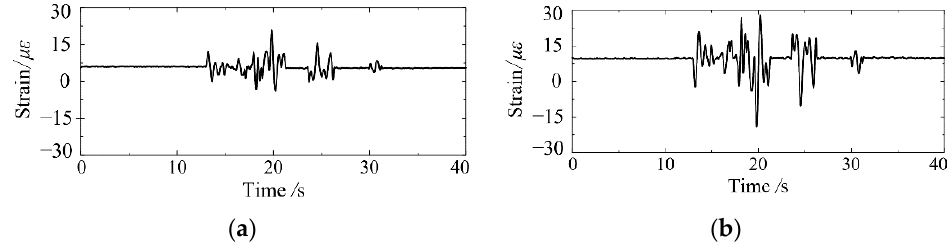
Figure 14. The strain responses at point S1 are caused by: ( a ) bending moment and ( b ) axial force.